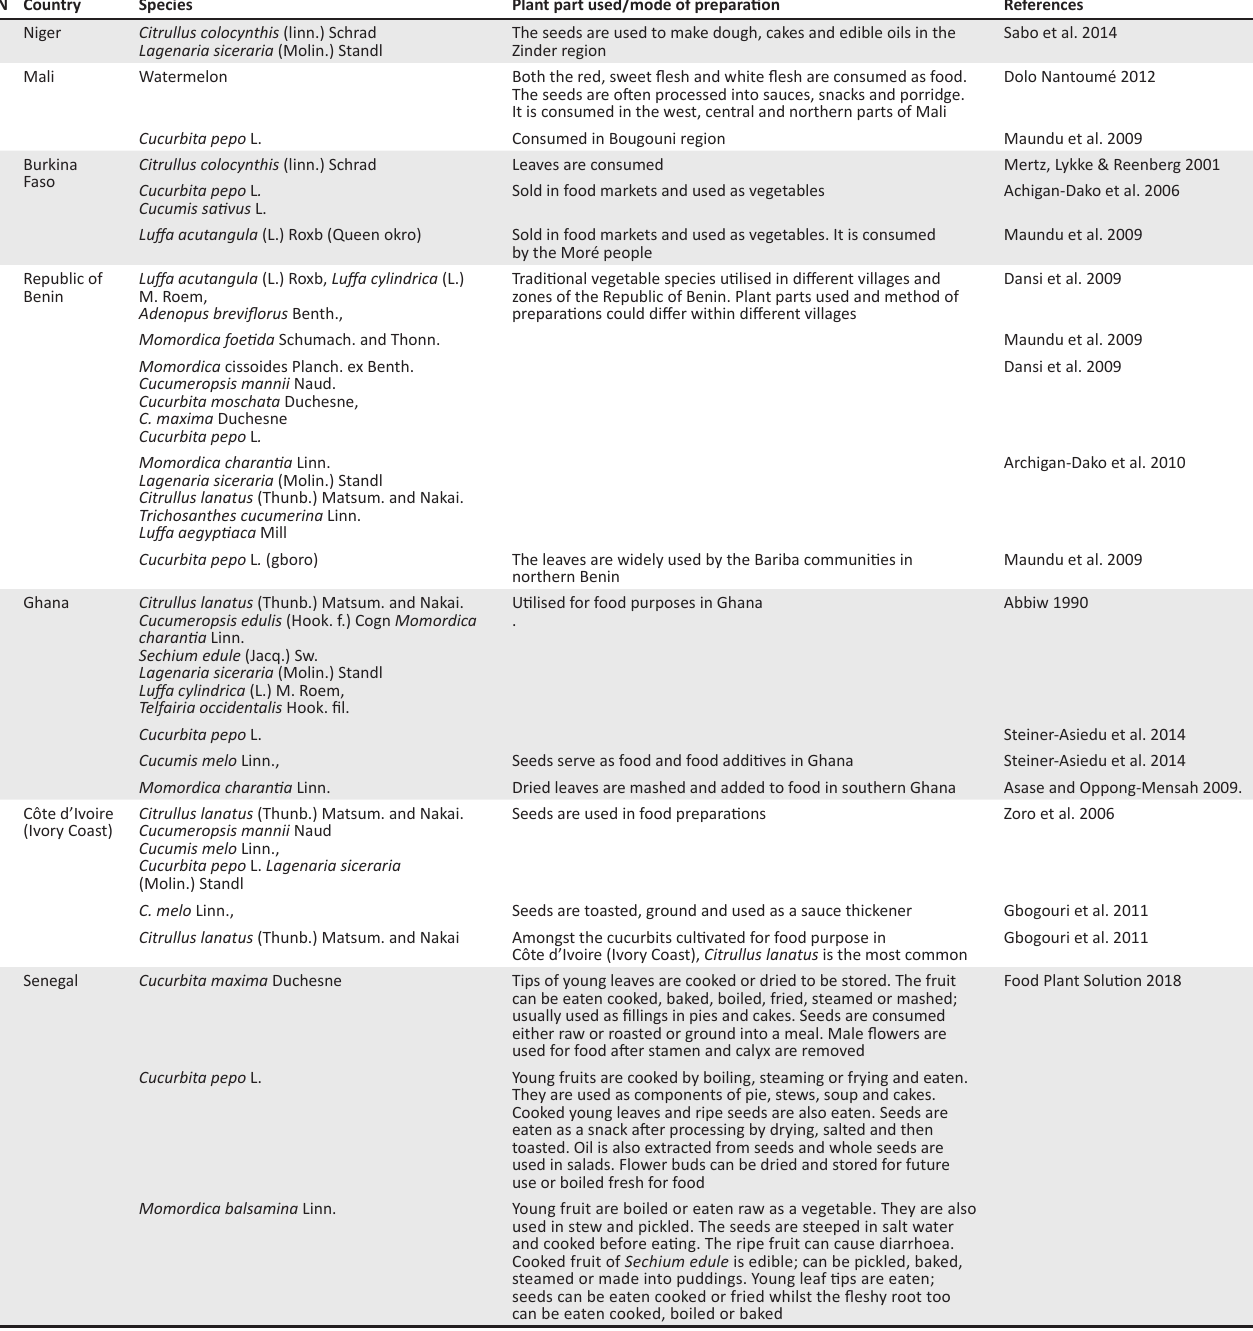
TABLE 1: Summary of Cucurbitaceae species used for food purposes in West African countries. SN